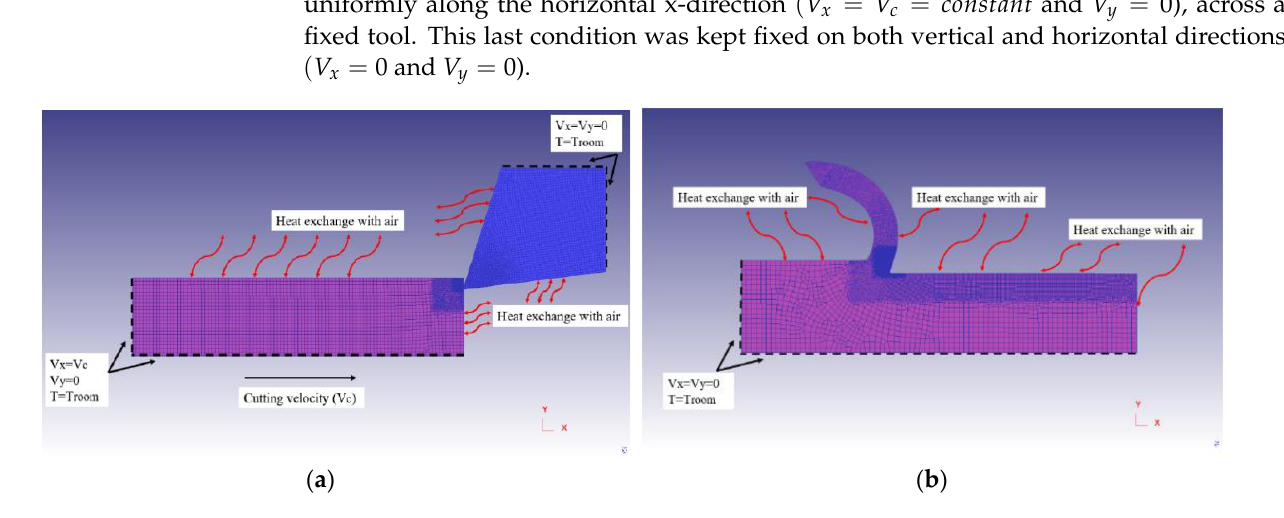
Figure 3. BCs in DEFORM™ [3]. ( a ) For the elasto–plasto cutting model and ( b ) BCs for the residual stresses